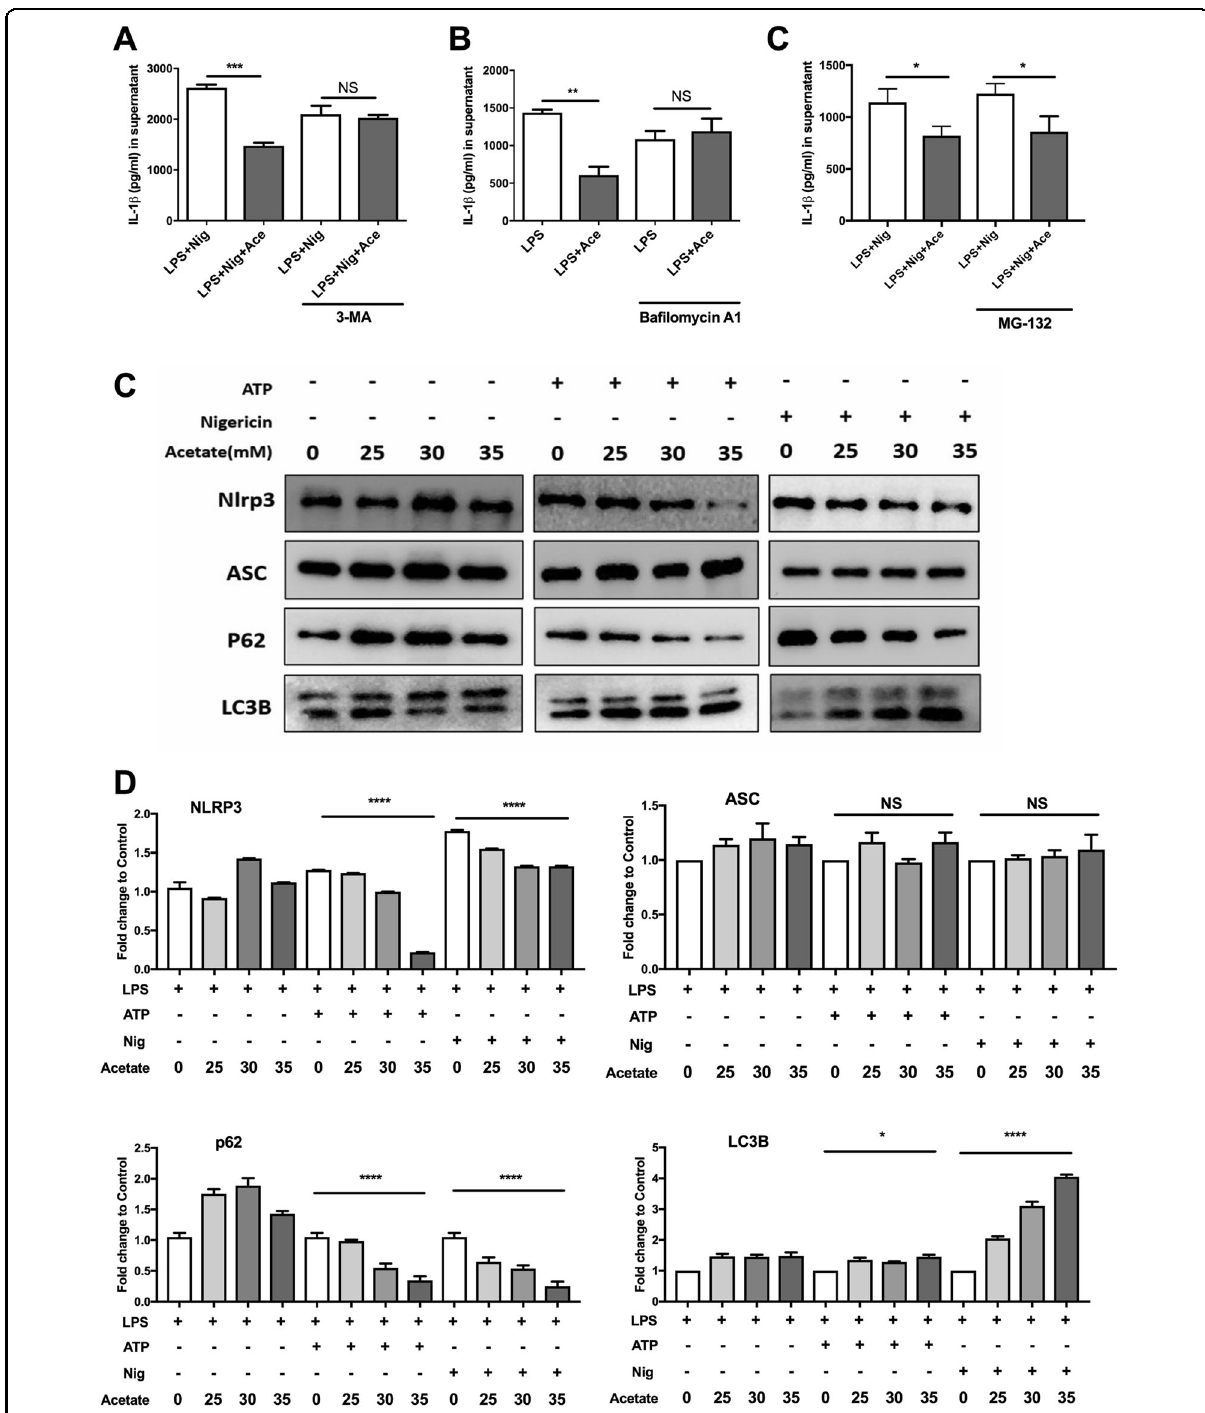
Fig. 6 Acetate promotes NLRP3 degradation through autophagy. a – c ELISA of IL-1 β indicated that acetate (25, 30, and 35 mM) mediated suppression of the NLRP3 in fl ammasome in a manner dependent on autophagy but not the proteasome. Inhibition of autophagy (3-MA and ba fi lomycin A1) reversed the suppression of IL-1 β ( a , b ), whereas inhibition of the proteasome induced few alterations ( c ) in BMDMs ( n = 3). c , d Western blot of NLRP3, ASC, p62, and LC3B. The degradation of NLRP3 was accompanied by increased NLRP3 expression and decreased p62 expression in BMDMs ( n = 3). n = biological replicates. Data are presented as the mean ± SEM. * P < 0.05, ** P < 0.01, *** P < 0.001, and **** P < 0.0001, Student ’ s t- test compared with the control group ( a – c ) or one-way ANOVA for comparisons of differences ( d